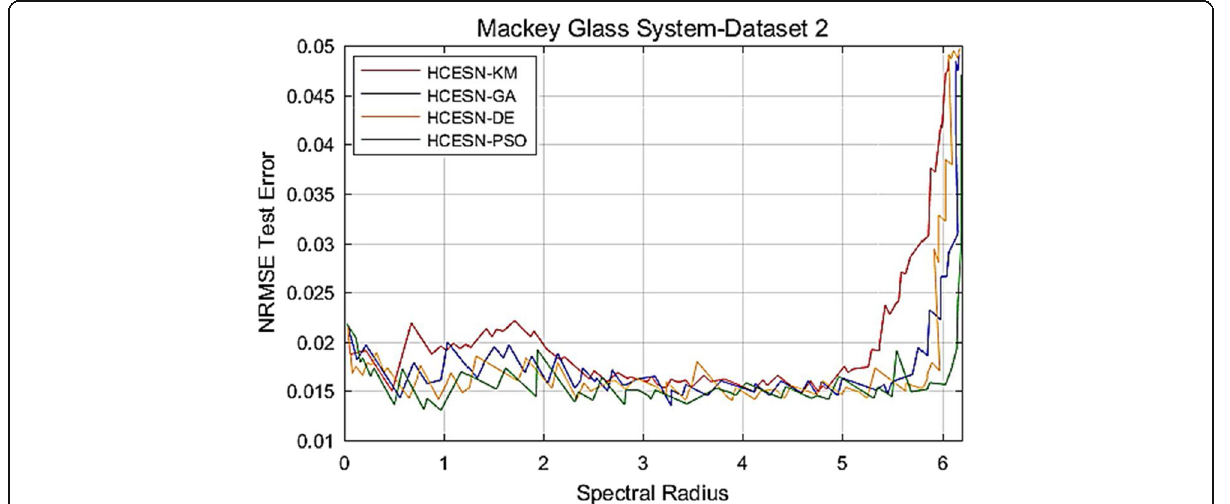
Fig. 5 NRMSE84 test error on dataset